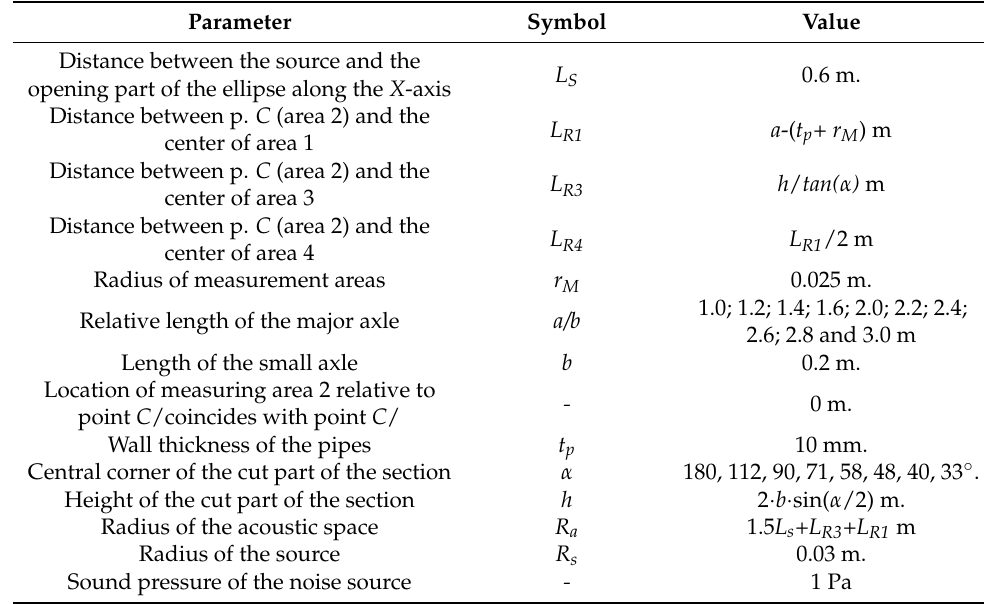
Table 1. COMSOL Model Parameters.